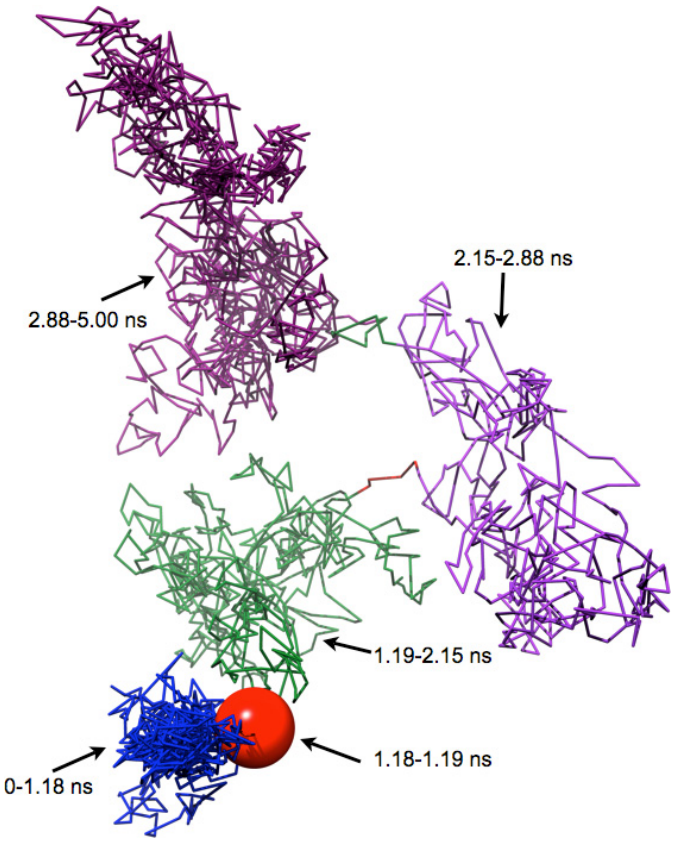
Figure 4. Vectorial representation of the first 5 ns of a 100 ns MDUF trajectory #1 in RMSD space obtained using the RMSD method of Daggett and coworkers [12,13]. The coloring distinguishes the various transitional intermediates.